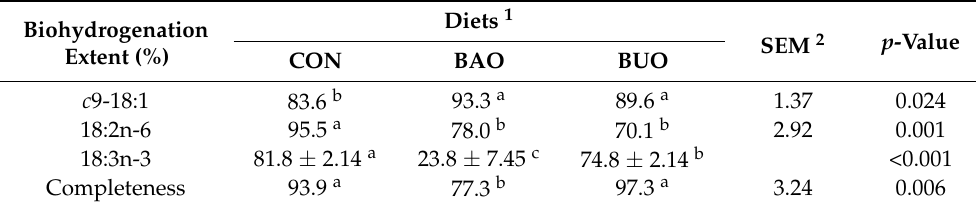
Table 6. Rumen biohydrogenation indicator estimates for lambs fed diets containing babassu or buriti oil.